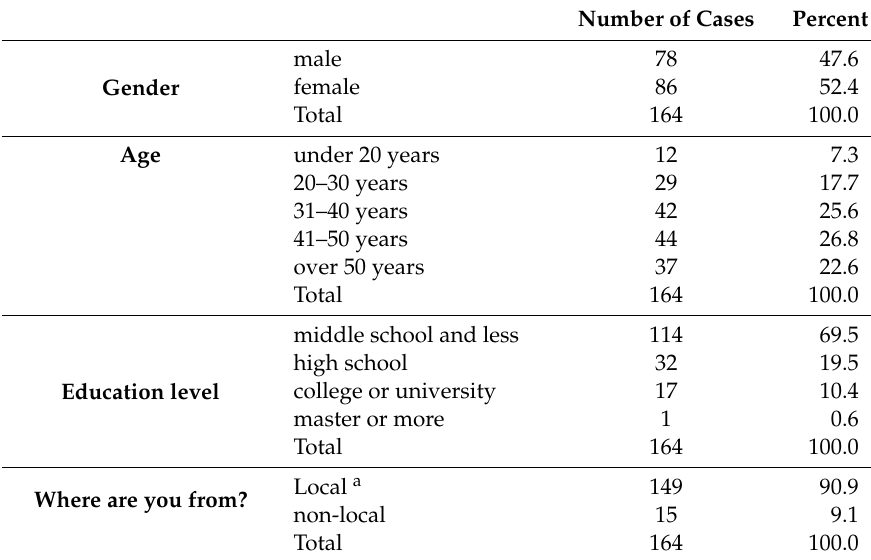
Table A1. Sample characteristics of the